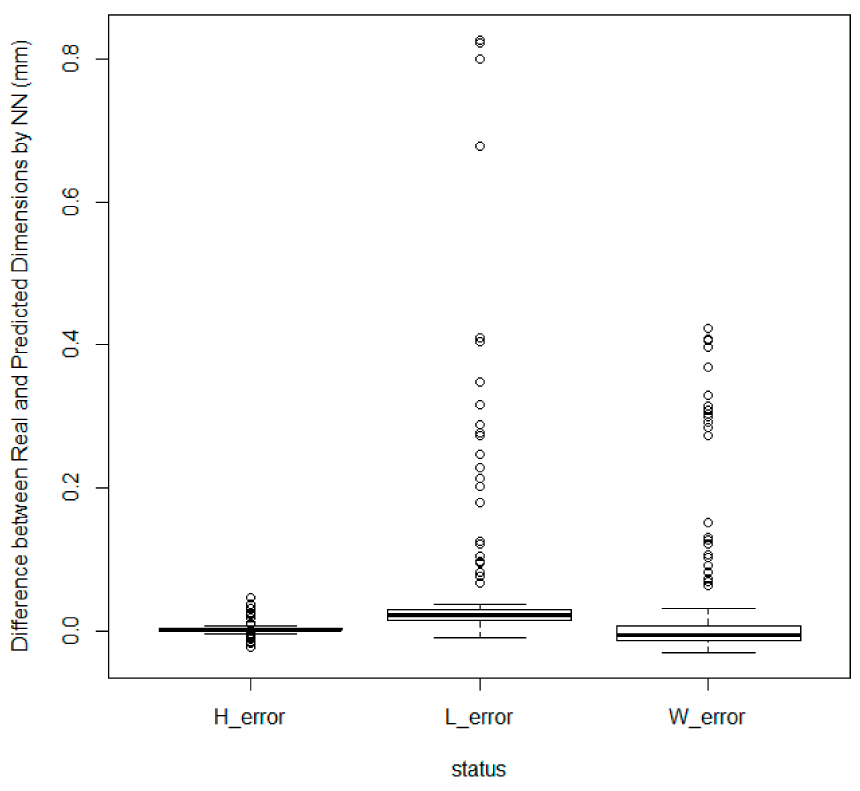
Figure 8. Difference between real and predicted CAD dimensions by NN.